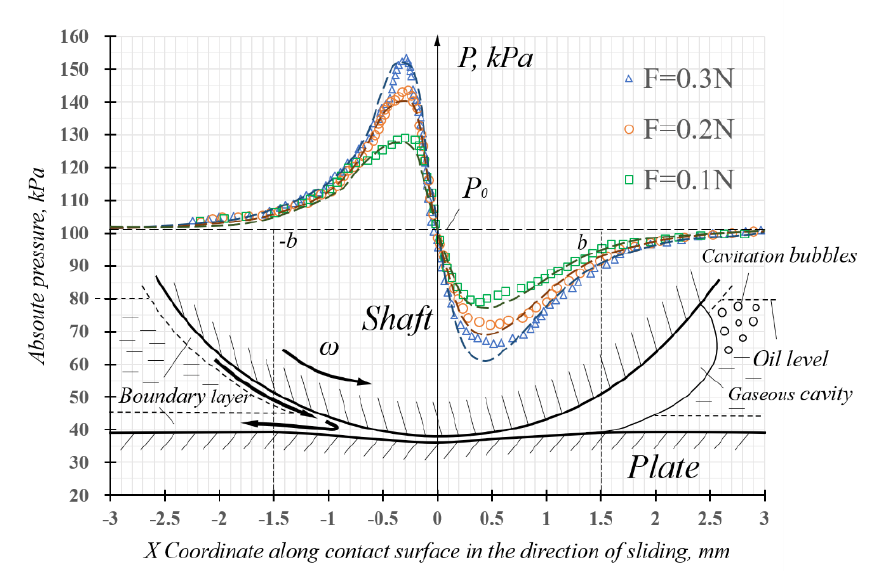
Fig. 4. Experimentally measured (solid lines) and calculated (dashed lines) values of local pressure in the